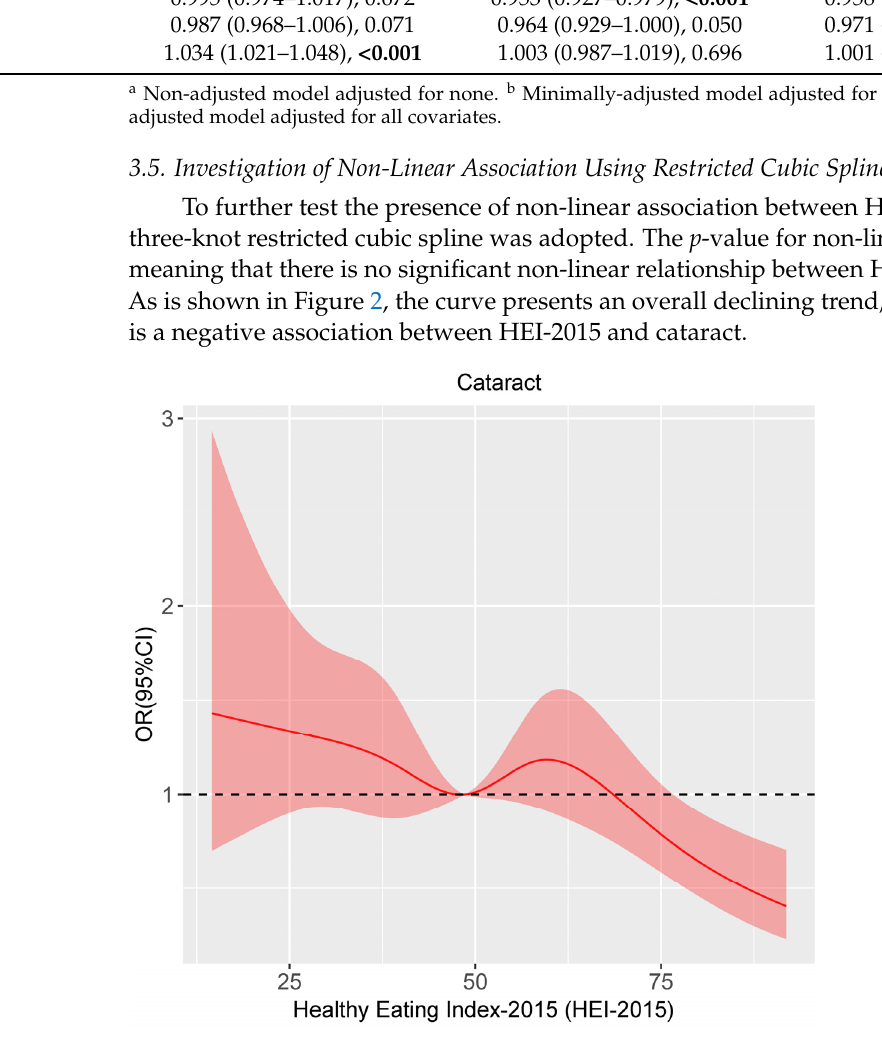
Figure 2. Restricted cubic spline analysis of the association between HEI-2015 and cataract.